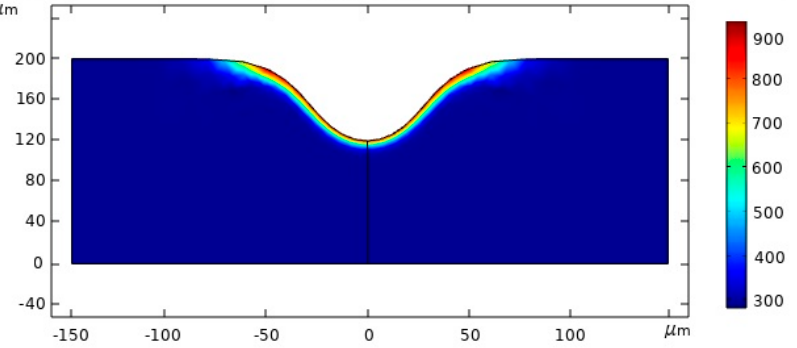
Figure 5. Cross section morphology of PMMA groove prepared by femtosecond laser direct writing (K).